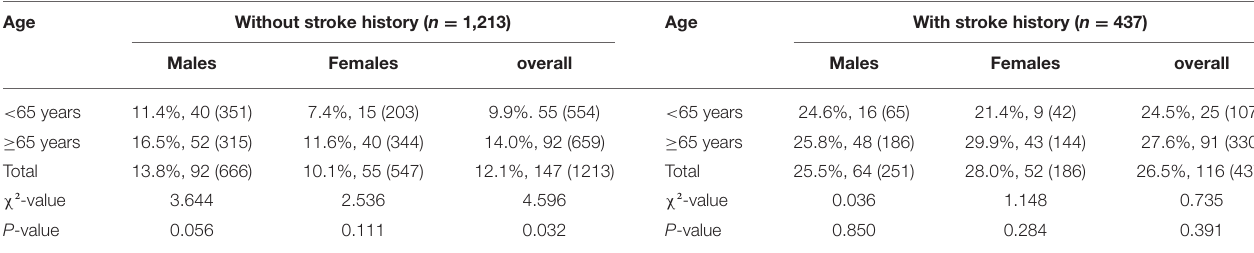
TABLE 2 | Incidence and recurrence rates of stroke by age groups and